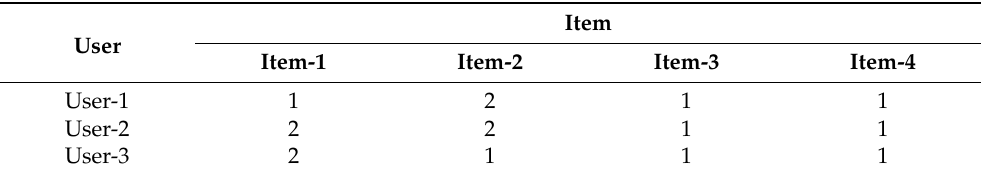
Table 2. The number of the same rating data given by users.